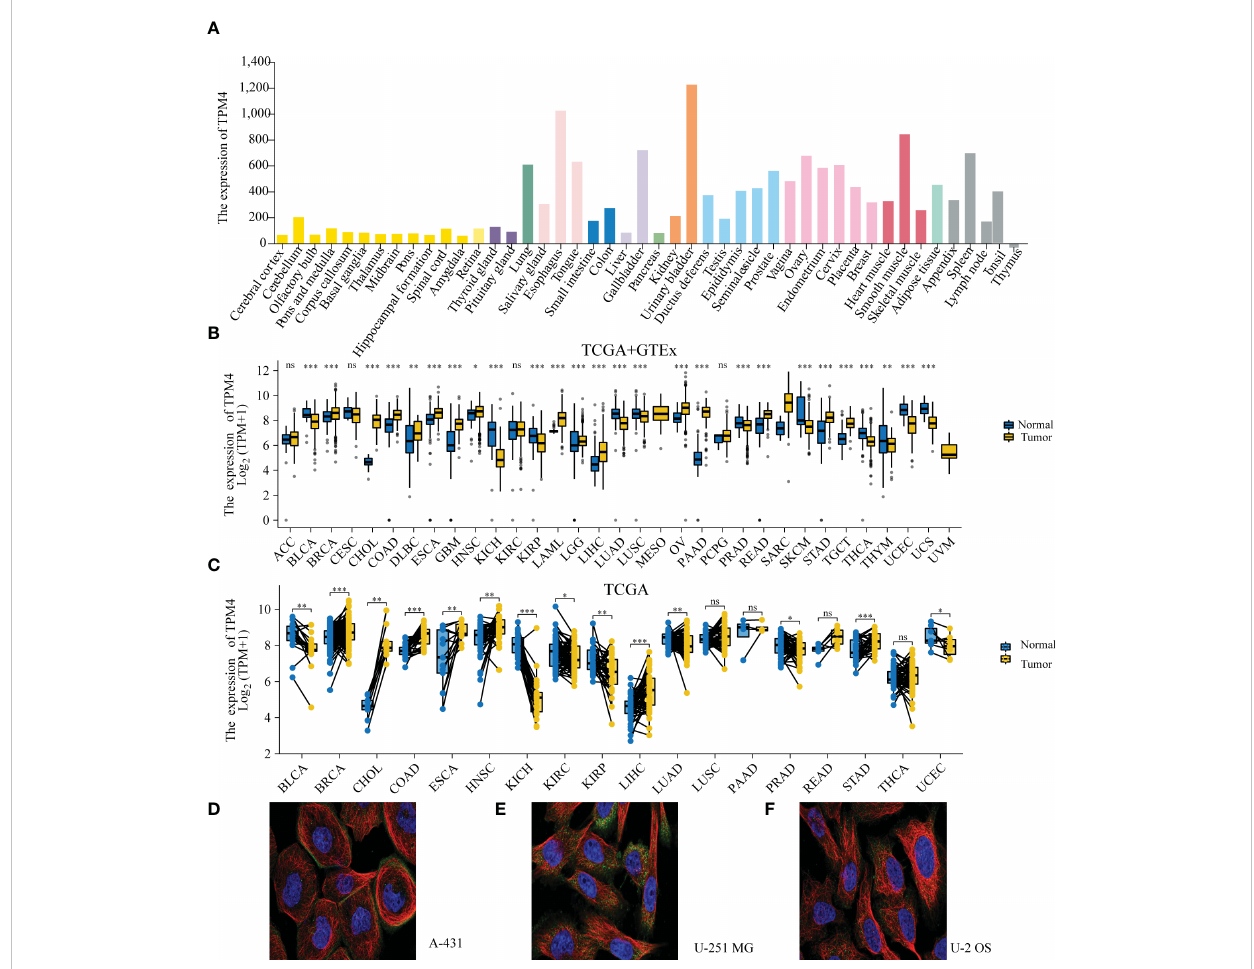
FIGURE 2 TPM4 expression levels and localization. (A) Expression levels of TPM4 in normal tissues based on HPA (n=13084). (B) TPM4 mRNA expression between tumors and normal tissues from TCGA+ GTE (N= 15,776). (C) The expression of TPM4 in tumors and paired adjacent normal tissues from TCGA (n=15043). (D-F) . Subcellular localization of TPM4 in A-431 cells from HPA datasets (D) . U-251MG cell line (E) , U-2 OS cell line (F) (ns, P ≥ 0.05; *P < 0.05; **P < 0.01; ***P <